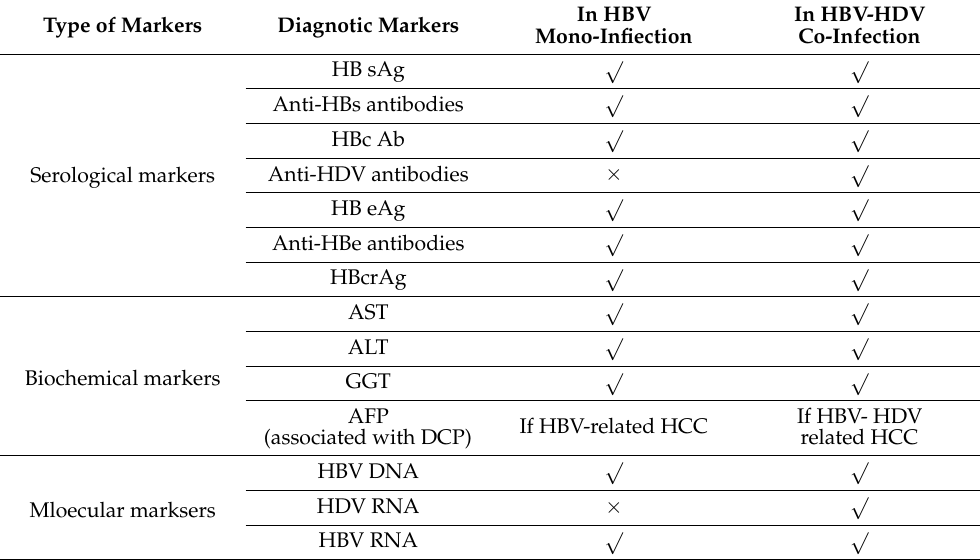
Table 1. Serological, biochemical and molecular markers for HBV monoinfection and HBV/HDV